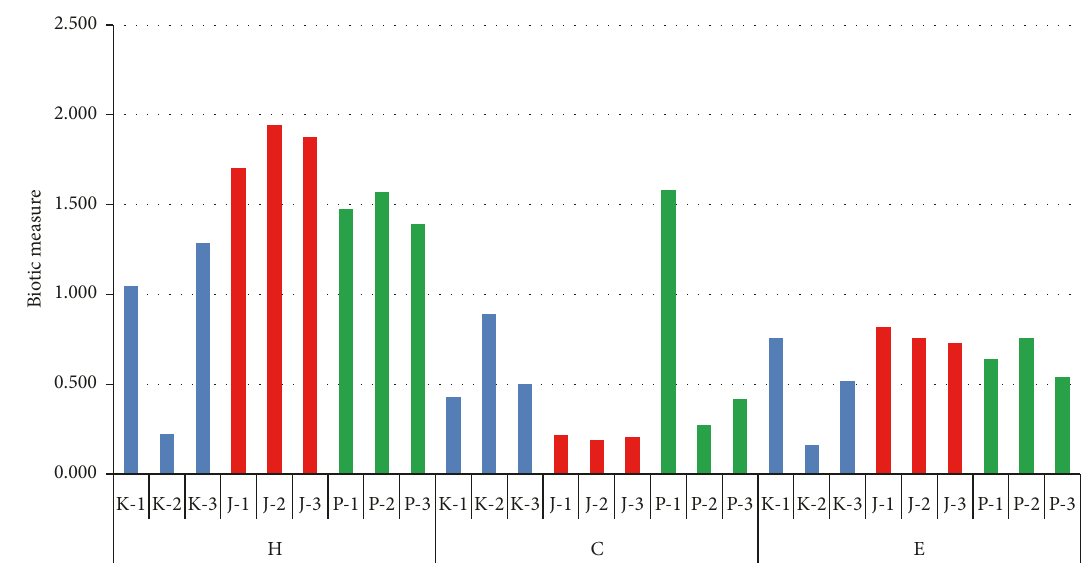
Figure 3: Diversity Index (H), Dominance Index (C), and Evenness Index (E) in June